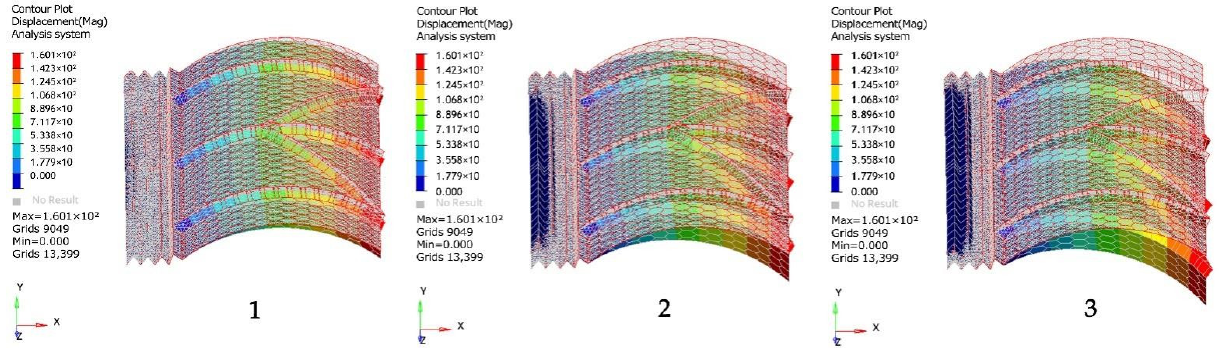
Figure 7. Deformation of the roof under vertical load. 1 is the initial deformation of the roof, 2 is the middle deformation of the roof, 3 is the severe deformation of the roof.